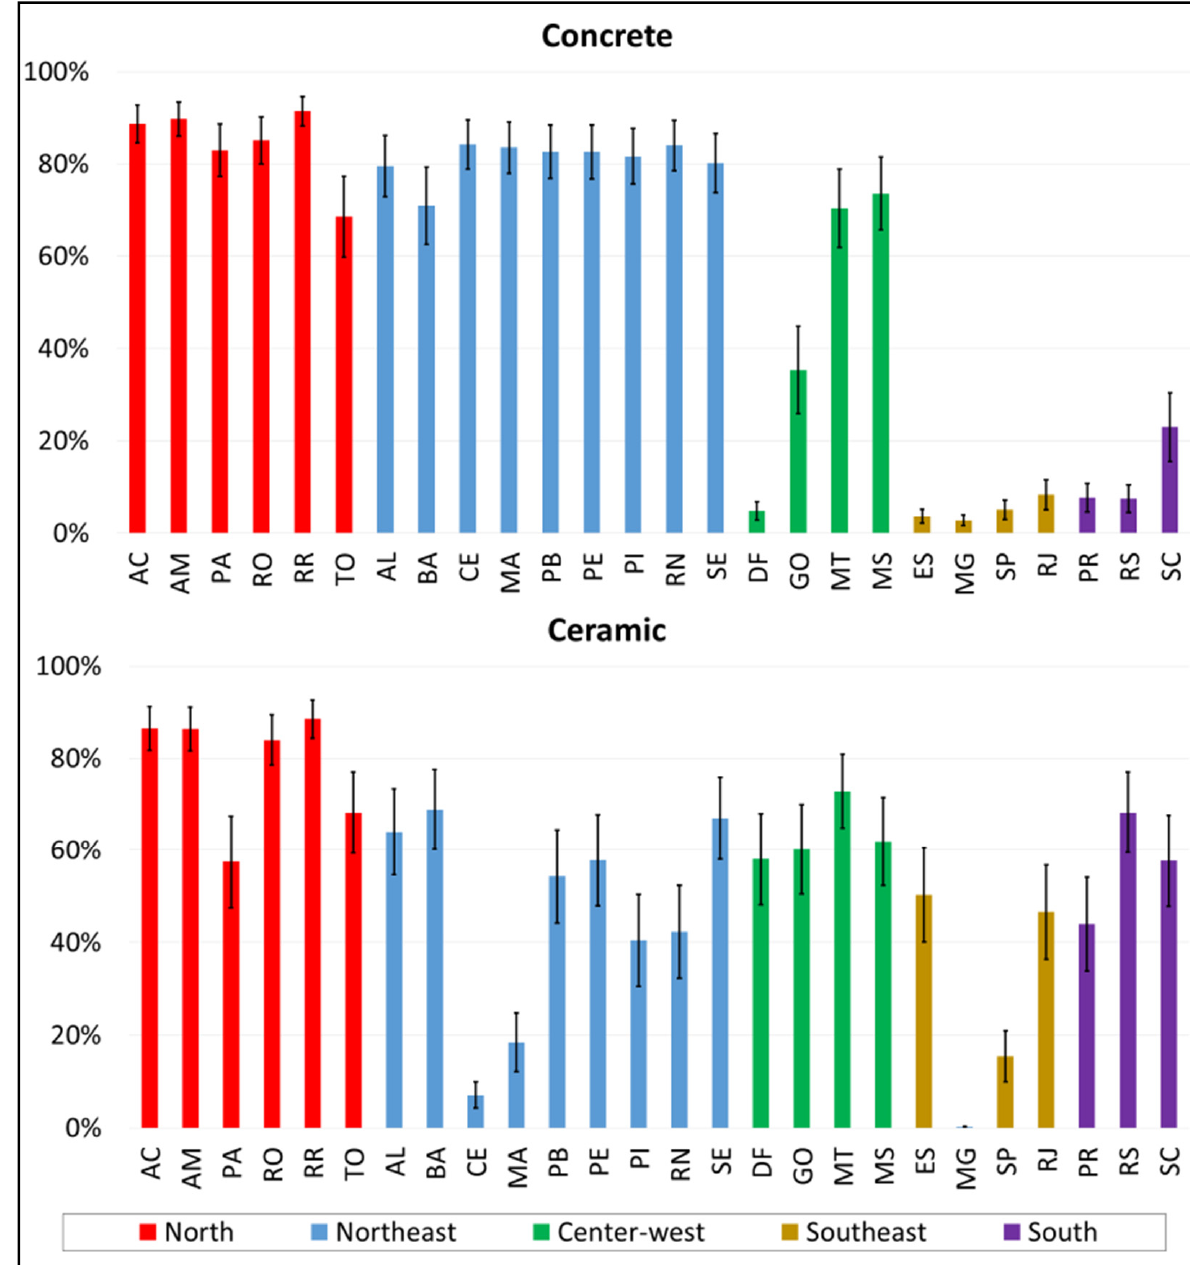
Figure 9. Percentage of the transportation stage in the Human Health impact. The error bars represent the standard deviation due to transportation scenarios.